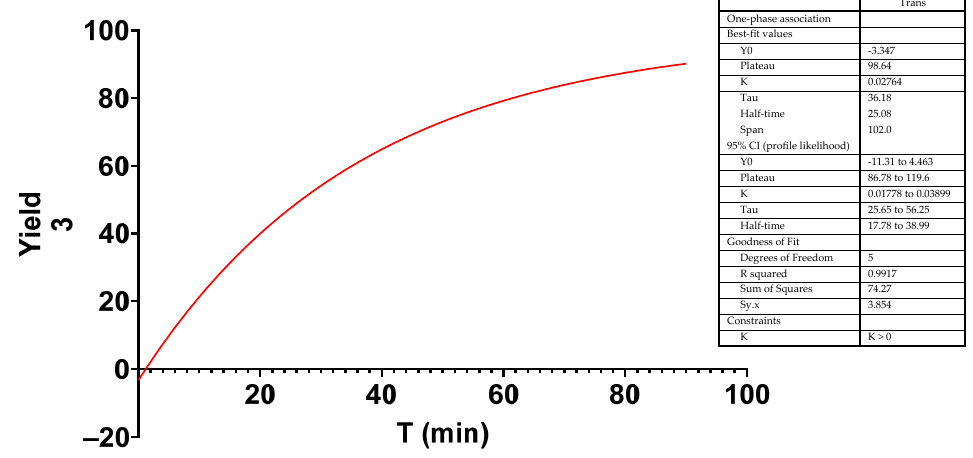
Figure 1. Yield of formation of 3 in CDCl 3 after photoisomerization of 4 at different times of irradiation.